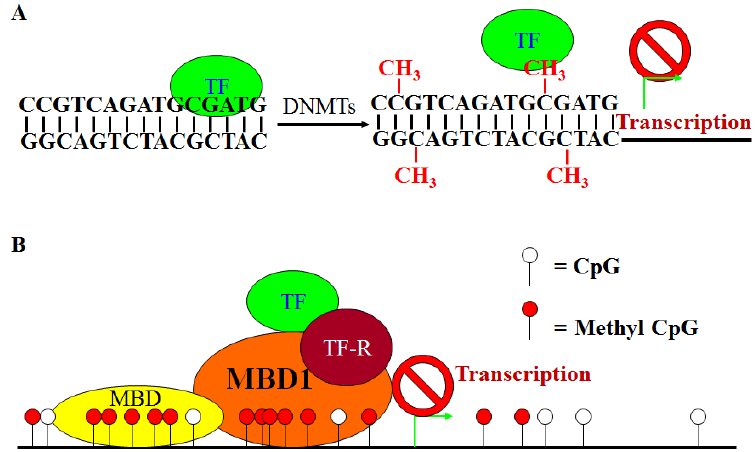
Figure 1. A simplified model of DNA methylation-mediated gene silencing. ( A ). Methylation of the cytosine of the CpG dinucleotides in a gene promoter region within a transcription factor’s binding consensus sequence motif may be recognized by the transcription factor (TF) as a ―mutation‖ and thus results in loss of TF binding and transcription initiation. ( B ). Methyl-CpGs may recruit MBD protein binding to the methylated DNA region in a gene promoter region. The MBD proteins may physically block TF binding to the promoter region or recruit repressors to inhibit TF activity, and thereby silencing gene